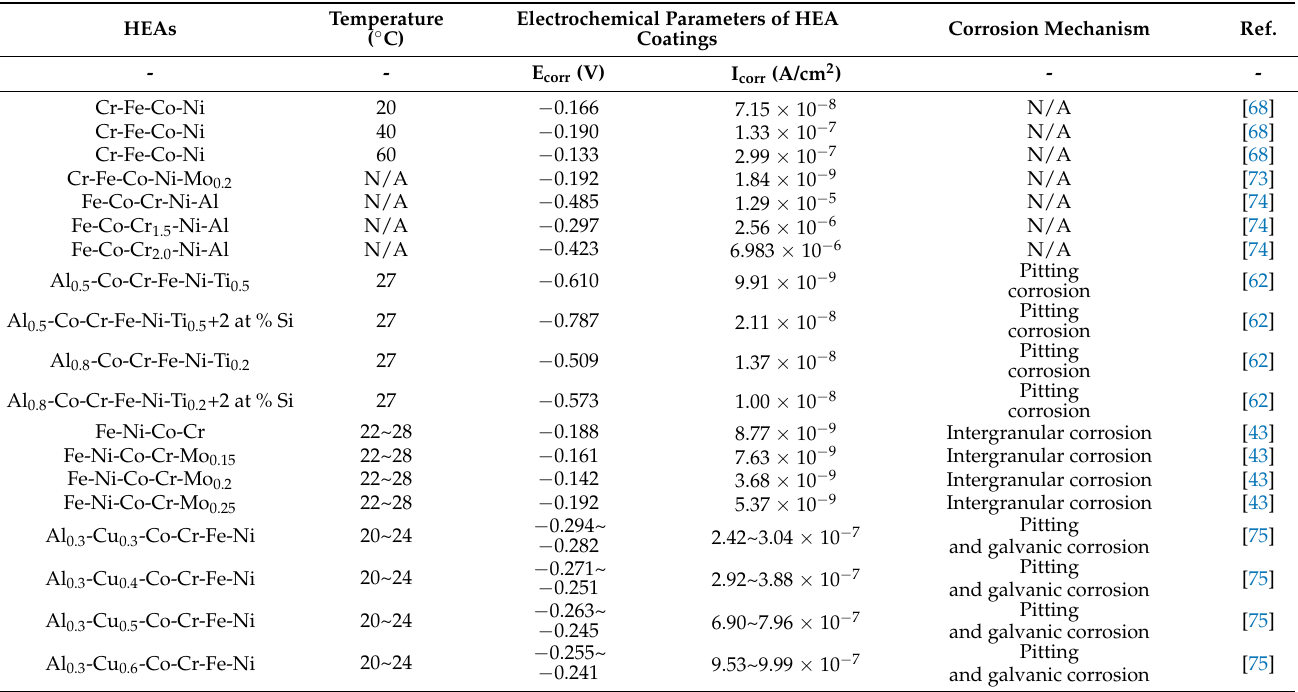
Table 4. The effects of 3.5 wt % NaCl (pH = 7) at different temperatures on the corrosion resistance of HEA coatings.